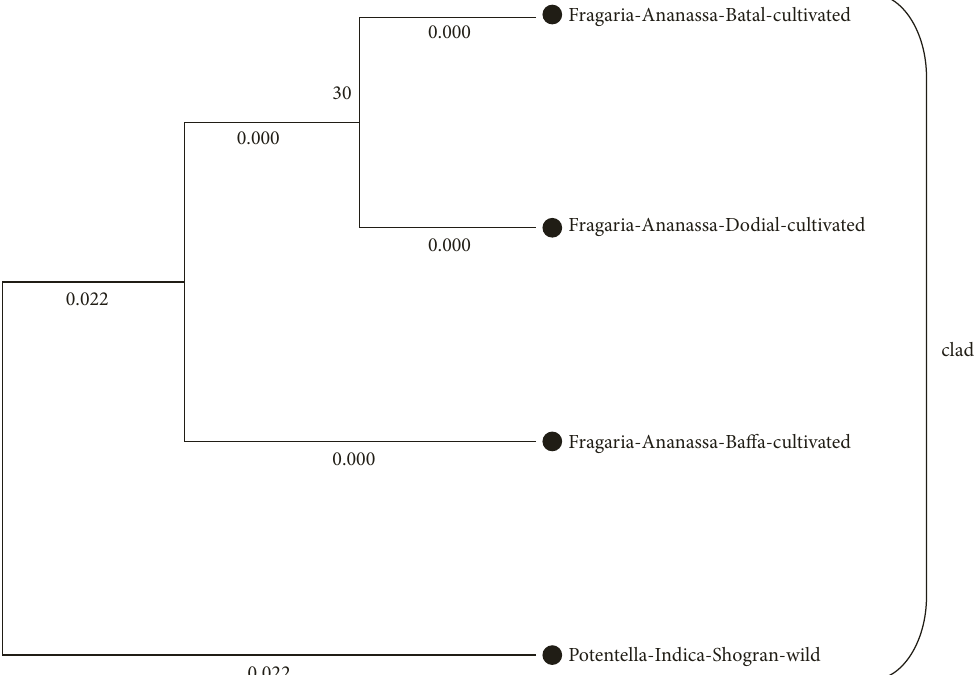
Figure 8: Phylogenetic tree of cultivated Fragaria species sequences of ( rbclC ) through the maximum likelihood